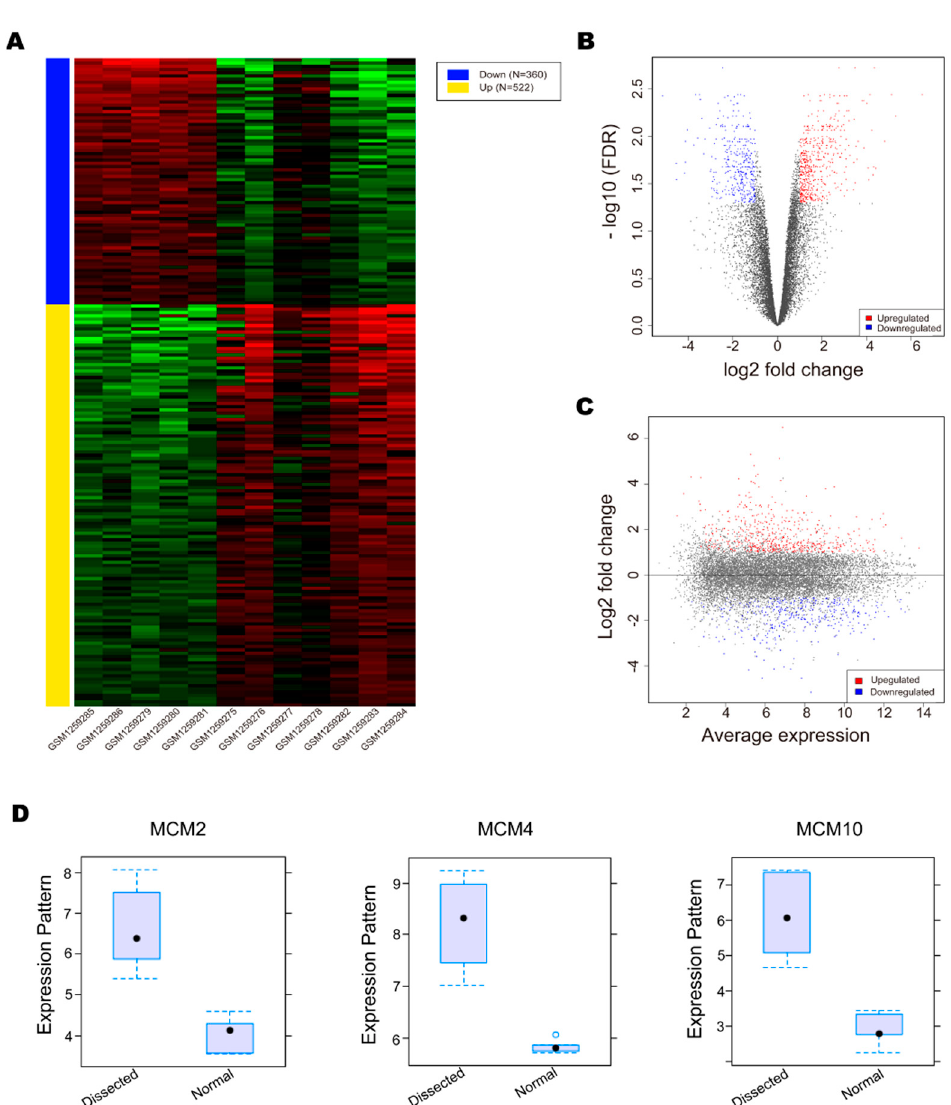
Figure 2. Identification of differentially expressed genes (DEGs) and the expression of minichromosome maintenance proteins (MCMs). ( A ). The heatmap of the DEGs. Blue: downregulated genes, n = 360; yellow: downregulated genes, n = 522. ( B ). The volcano plots of the DEGs. ( C ). The scatterplots of the DEGs. ( D ). The expression of MCM2, MCM4, and MCM10.